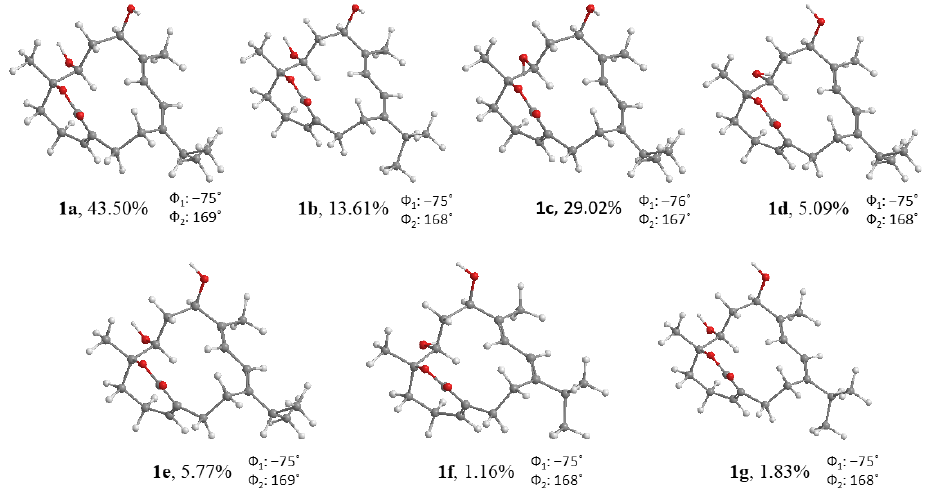
Figure 3. Low-energy conformers, populations, and dihedral angles ( Φ 1 (H7-C7-C6-H6 pro-S ) and Φ 2 (H7-C7-C6-H6 pro-R )) of 7 S * ,8 R * - 1 at CAM-B3LYP/6-31+G(d,p) IEFPCM (CHCl 3 ) level of theory.